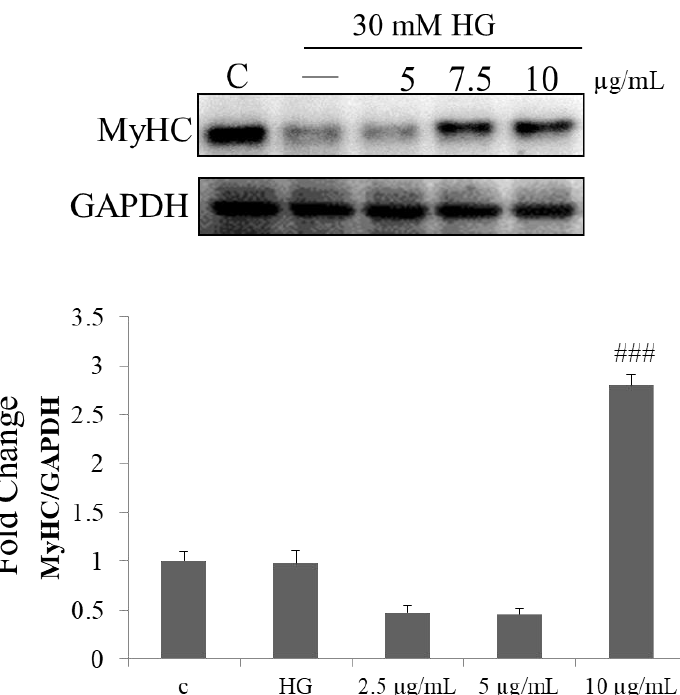
Figure 6. PPH902 on the effect of HG-induced myogenic differentiation. Representative Western blotting shows changes in the levels of MyHC in C2C12 cells. ### p < 0.001 indicates a significance difference with respect to the high glucose challenge groups.